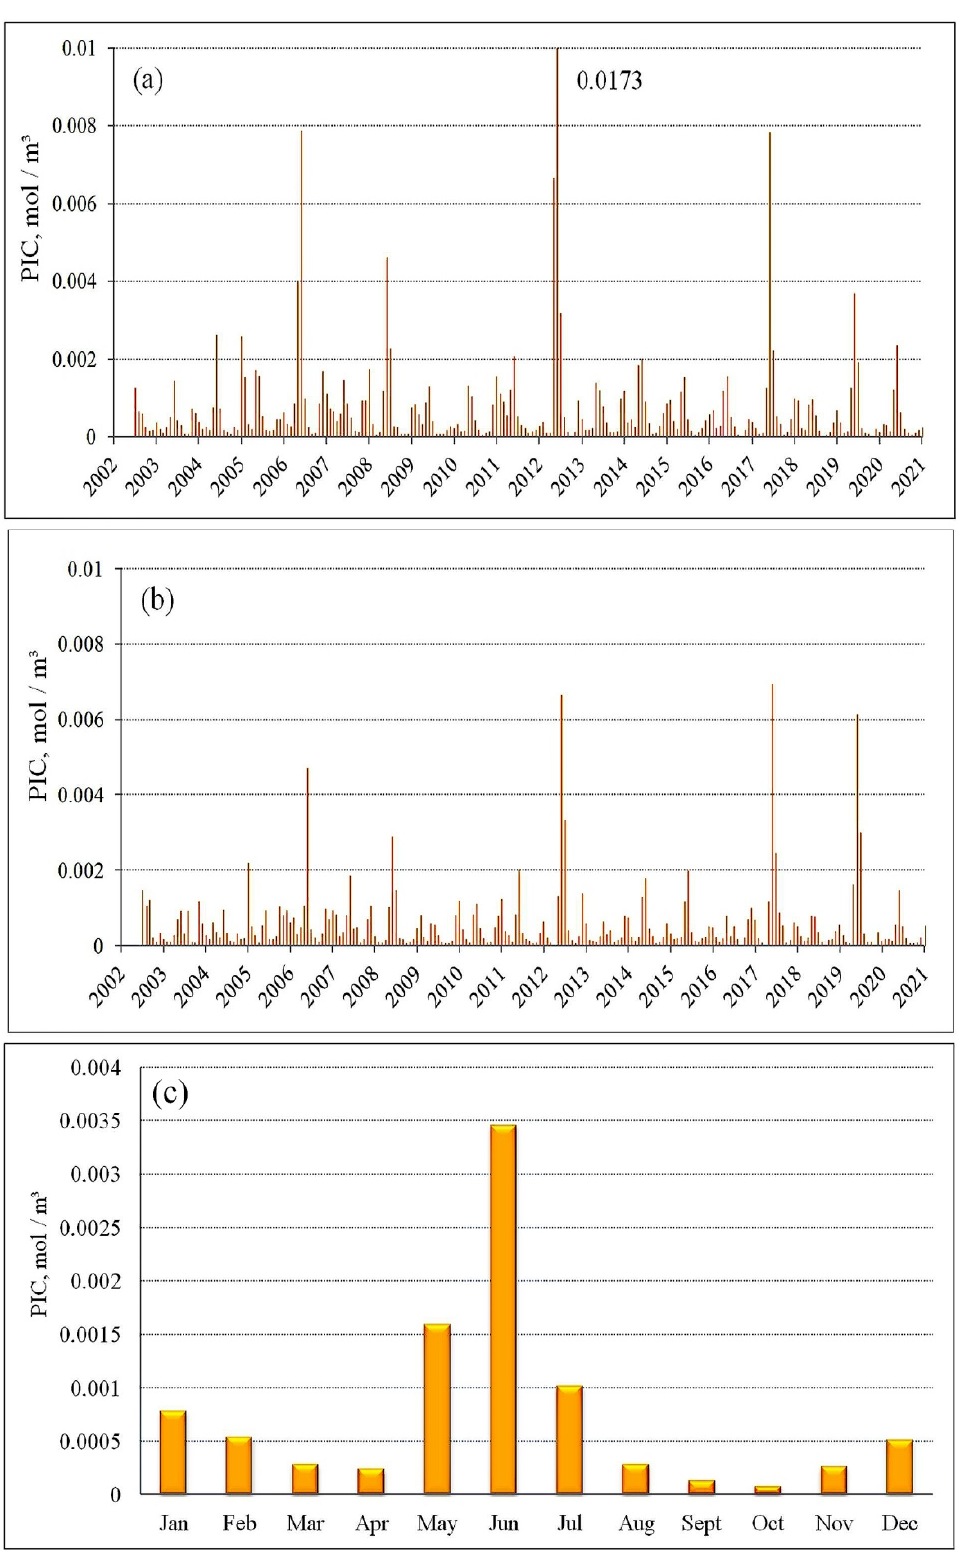
Figure 3. Long-term dynamics of coccolithophores in the Black Sea expressed as PIC concentrations: Eastern gyre ( a ), Western gyre ( b ) and averaged seasonal changes in PIC content in the open Black Sea ( c ) according to the MODIS-Aqua.